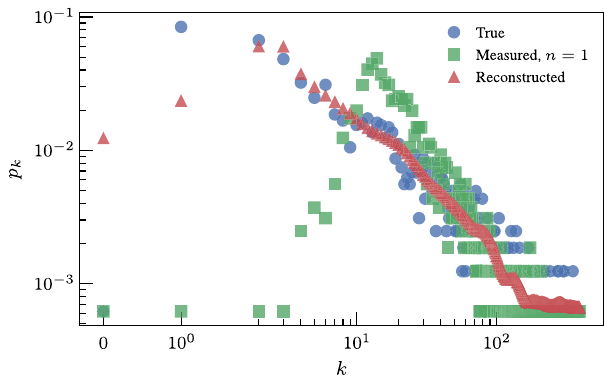
FIG. 6. True, measured (with n ¼ 1 ), and reconstructed degree distributions of the political blog network, with noise magnitudes ð p; q Þ ¼ ð 0 . 41 ; 0 . 0094 Þ